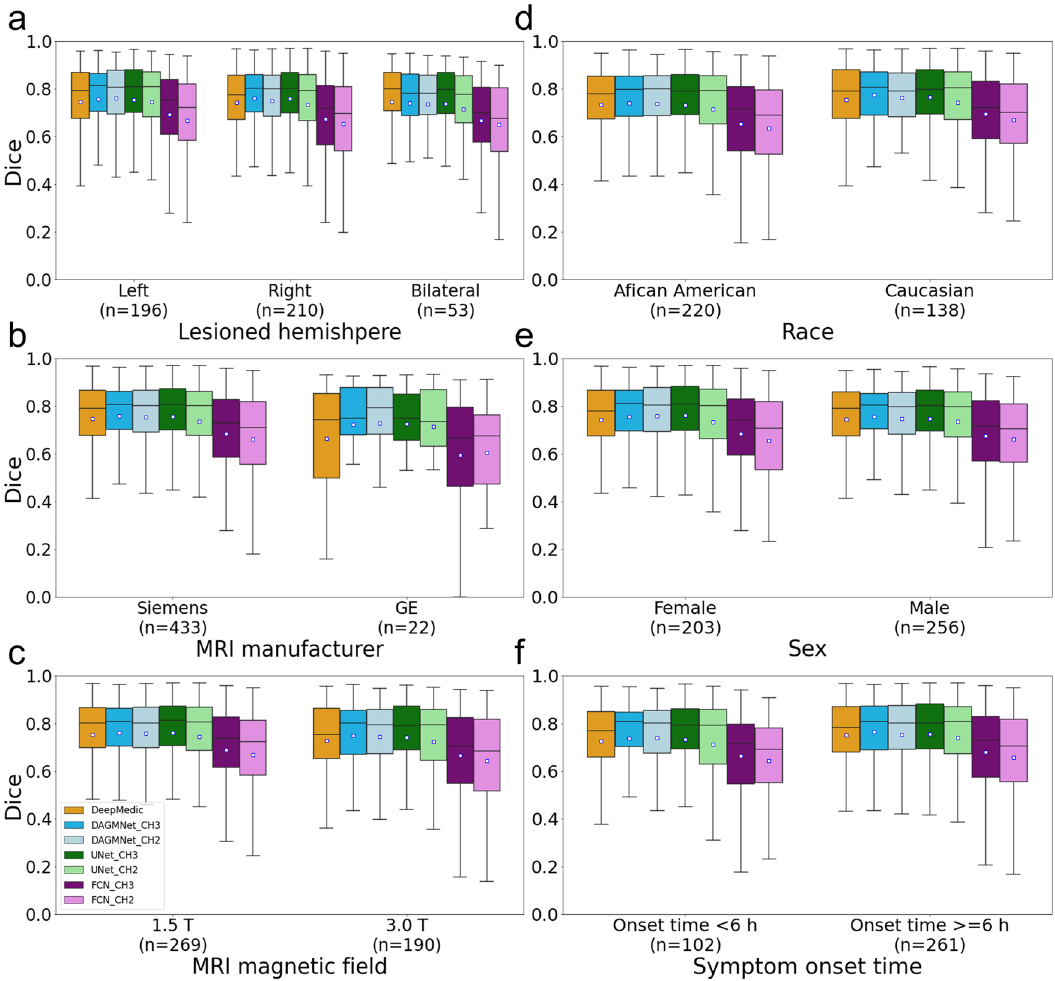
Fig. 5 Performance of all models (DeeMedic, DAGMNet, UNet, FCN) in the Testing dataset. The performance is shown according to ( a ) lesion hemisphere, ( b ) scanner manufacturer, ( c ) MRI magnetic fi eld, ( d ) patient ’ s race, ( e ) patient ’ s sex, and ( f ) symptom onset to MRI time. In each Whisker ’ s boxplot, the white square indicates the average; the black trace indicates the median. The whisker is a representation of a multiple (1.5) of the interquartile range (IQR). All the sub- fi gures share the same legends as sub- fi gure ( c